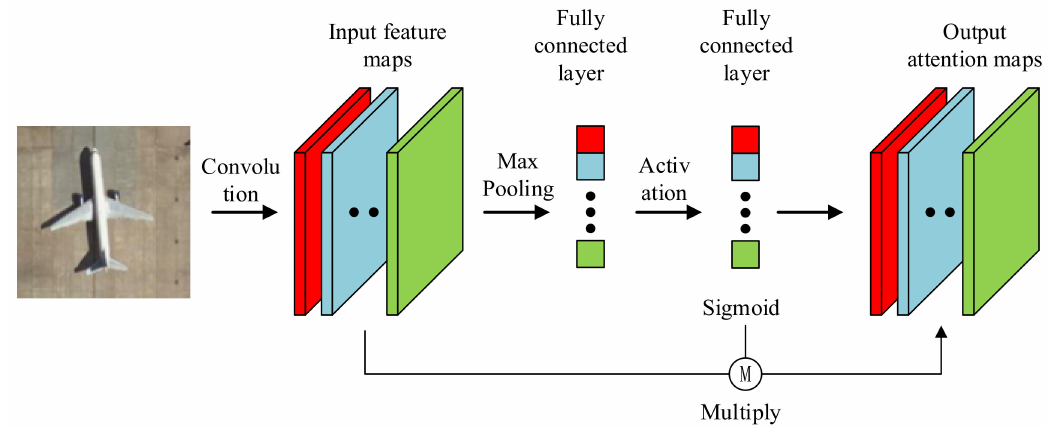
Figure 3. Architecture of the channel attention